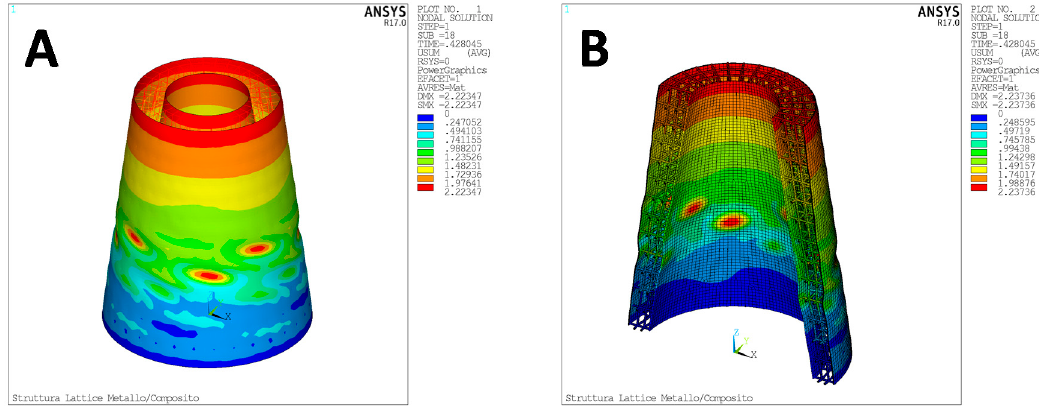
Figure 18. Test case 1—Non-linear analysis—total displacement at critical compressive load.